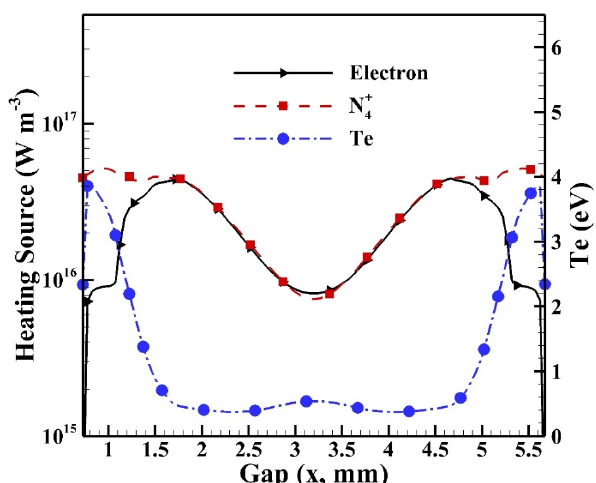
Figure 14. The cyclic average distributions of electron, dominant ion N 4+ , and electron temperature (Te) in the gap.